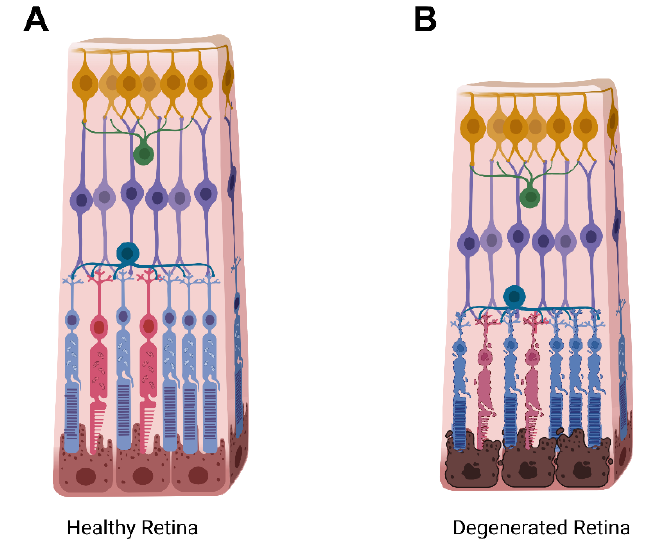
Figure 2. Cartoon schematic of a healthy retina in comparison to a degenerating retina. ( A ) Illustration of the retinal layers in an intact, healthy, retina. ( B ) Illustration of a degenerating retina with rod photoreceptors depicted in blue, and cone photoreceptors depicted in red. The total retinal thickness, as well as the outer nuclear layer containing the rods and cones thins upon degeneration as photoreceptor cells shrink, lose functionality, and die. Yellow, ganglion cells; green, amacrine cells; teal, horizontal cells; purple, bipolar cells; brown, retinal pigment